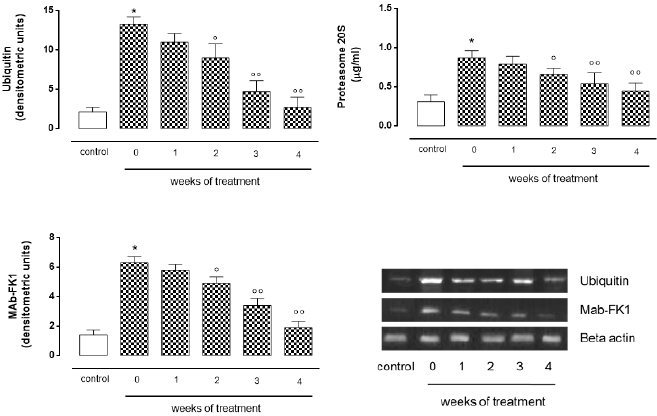
Figure 1. After different weeks of treatment with oral prednisone, levels of serum proteasome 20S were evaluated by ELISA test (Proteasome Elisa kit BML-PW057-0001, Enzo Life Science, Rome, Italy), while levels of ubiquitin and MAb-FK1 were evaluated by Western blotting with specific primary antibodies (anti-ubiquitin sc-8017, Santa Cruz Biotechnology, Heidelberg, Germany; anti-FK1 BML-PW8805-0500, Enzo Life Science, Rome, Italy) and anti-mouse secondary antibody (sc-2005, Santa Cruz Biotechnology, Heidelberg, Germany). Week 0 represents the acute attack of uveitis and the initiationof the prednisone therapy. Values are the means ± S.E.M. of three measurements for each time point. * p < 0.01 vs. control; o p < 0.05 vs. week 0; oo p < 0.01 vs. week